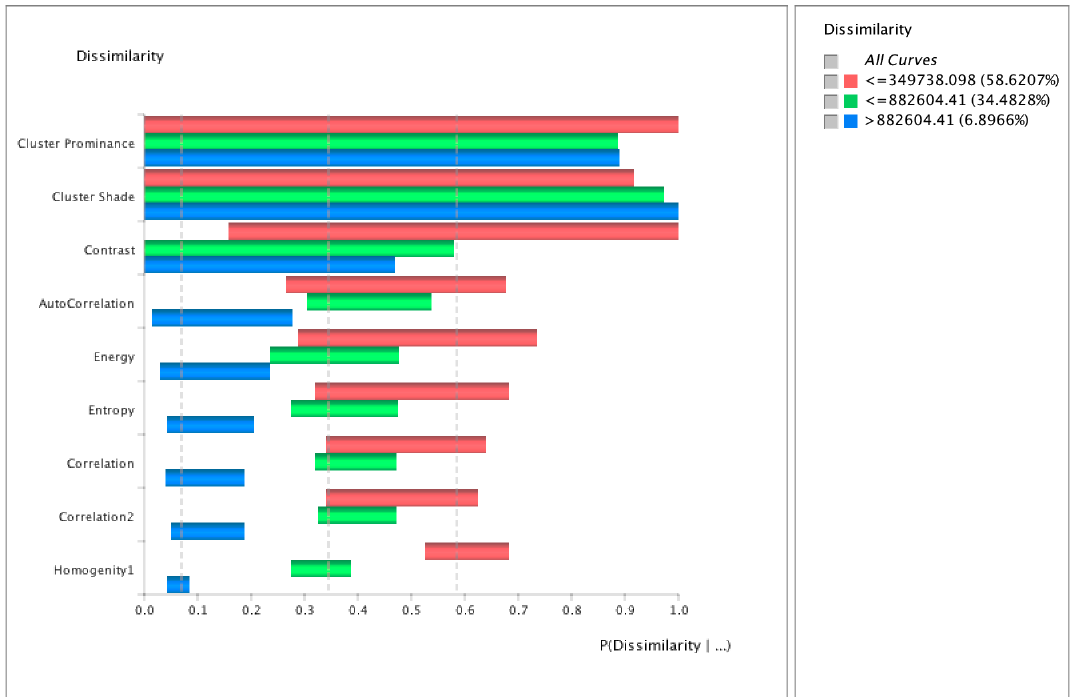
Figure 6. Significance of the dissimilarity node with all nodes at selected cluster states ( ≤ 349,738 (58.62%), ≤ 882,604 (34.48%), and >882,604